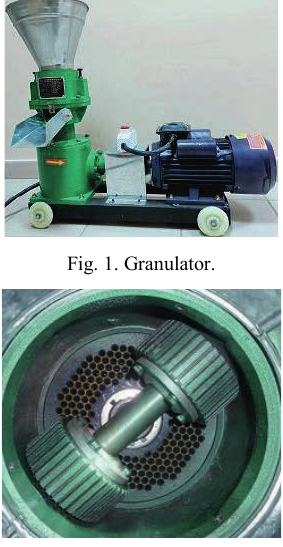
Fig. 2. The matrix and the rollers of the